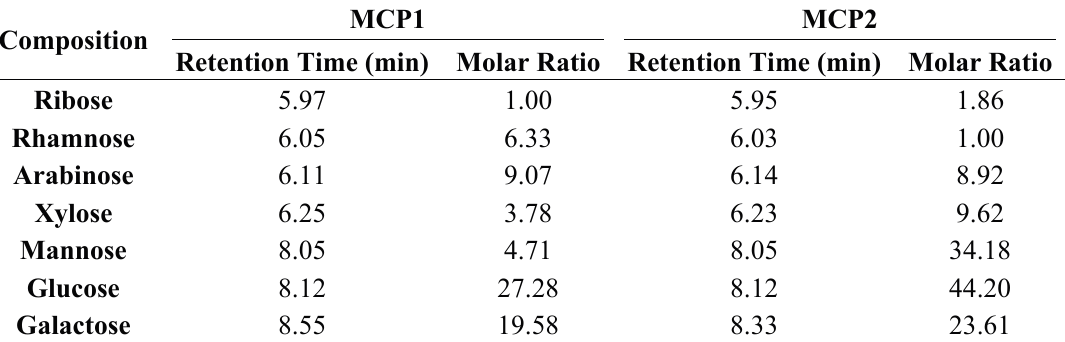
Table 3. Monosaccharide compositions of MCP1 and MCP2. The monosaccharide compositions of MCP1 and MCP2 were determined using gas chromatography–mass spectrometry.